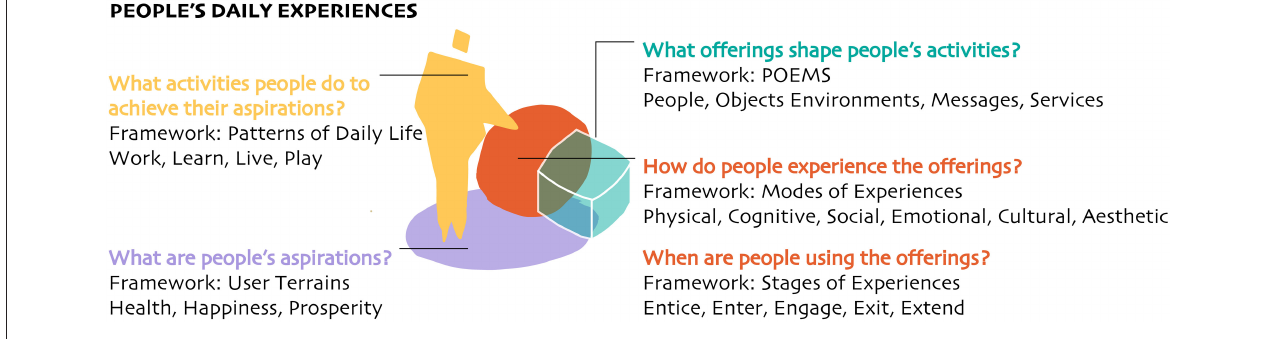
FIGURE 5 | The diagram above shows critical questions that designers ask to understand people’s experiences and related frameworks they use to organize information gathered during research. For example, POEMS, an acronym for people, objects, environments, messages, and services that compose systems of offerings, and User Terrains, that helps organizations understand their users in the context of their aspirations, rather than solely socio-economic and demographic